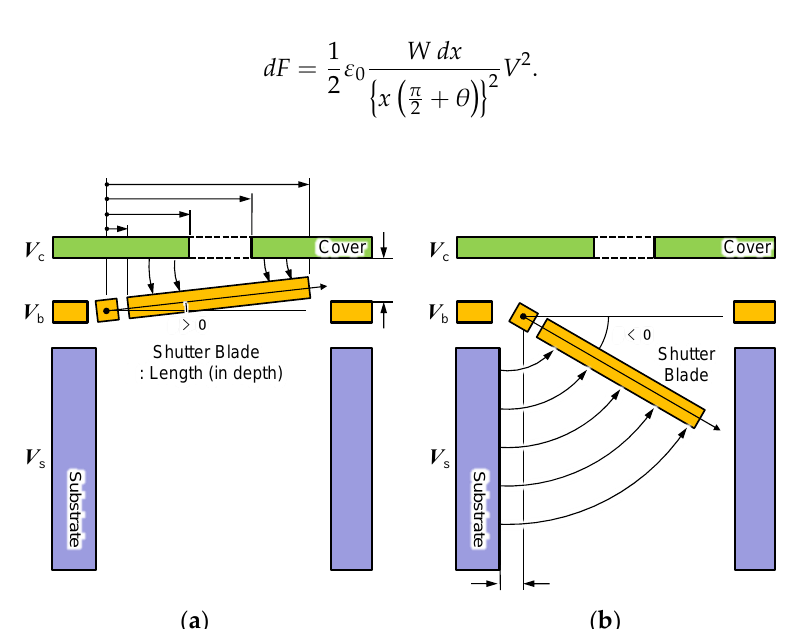
Figure 4. Side view of the three-port electrostatic mechanism. ( a ) Shutter blade being latched upwards to close the aperture, and ( b ) shutter blade being retracted inward to open the aperture. The electrostatic fields are represented by the arc for the simplicity of analysis. See Table 1 for the dimensions for the design parameters.